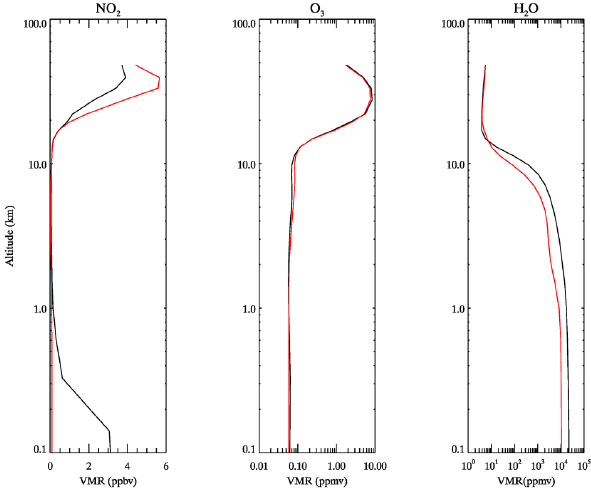
the modelled spectra retrieval for the polluted China (black) and the clean Pacific (red) scenarios. The profiles were taken from Veefkind